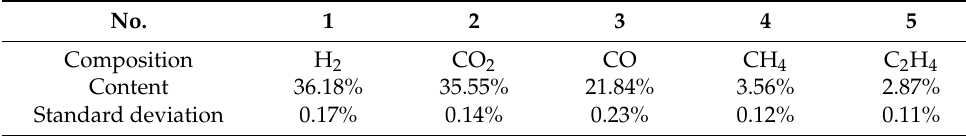
Table 3. Composition and content of gas product by Ar-plasma pyrolysis.